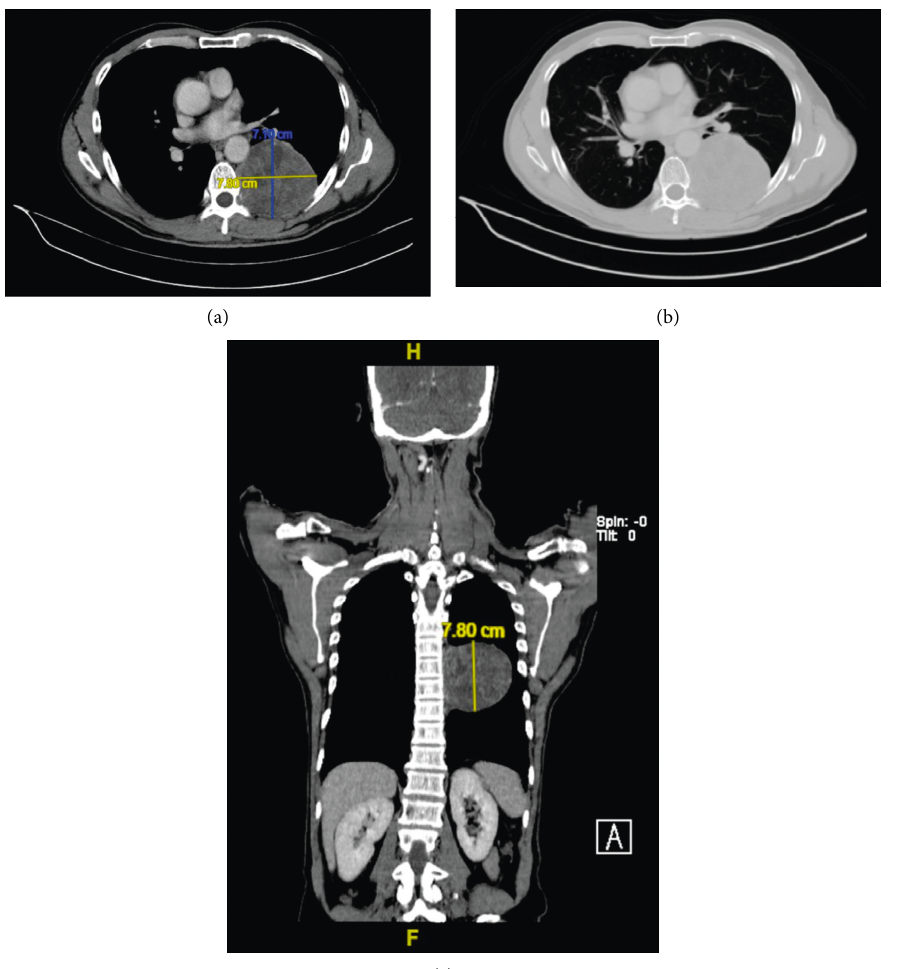
Figure 1: CTshowing a well-defined heterogeneously enhancing mass at the left paravertebral region with extension into left T7/8 neural foramina. (a)-(b) Axial view; (c) coronal